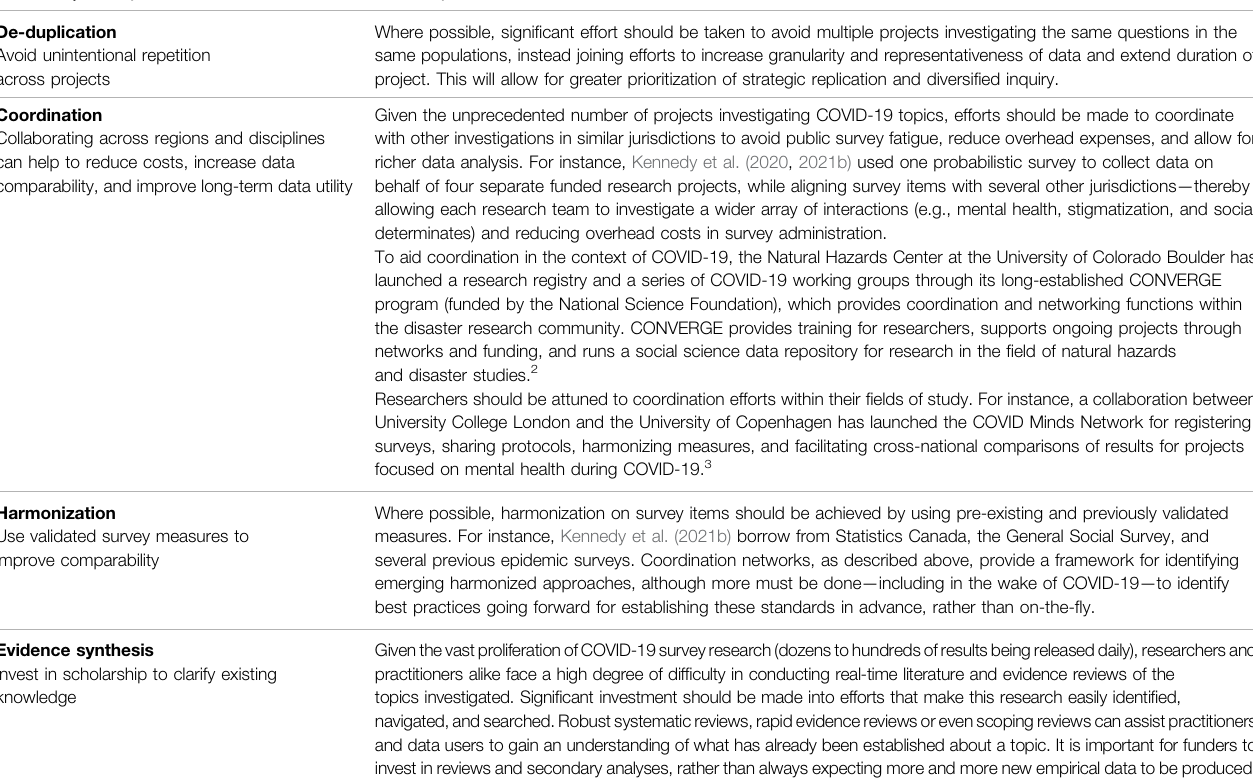
TABLE 3 | Primary considerations for coordination of survey-based COVID-19